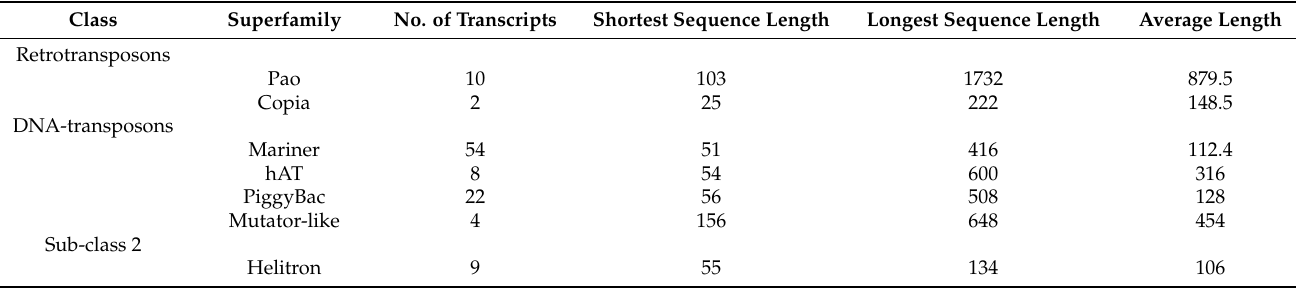
Table 2. Detailed information of the transcriptionally active transposable elements retrieved from the transcriptome of Schlechtendalia chinensis